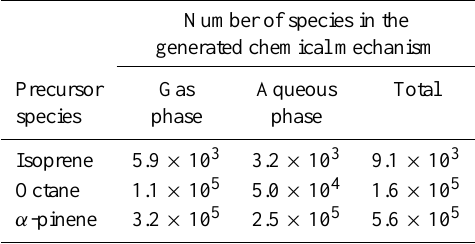
Table 1. Number of species generated in the full chemical schemes for the three precursor species. Number of species in